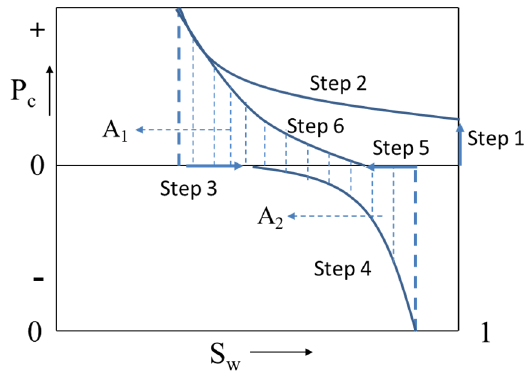
Figure 1. Combined Amott/USBM measurement process.